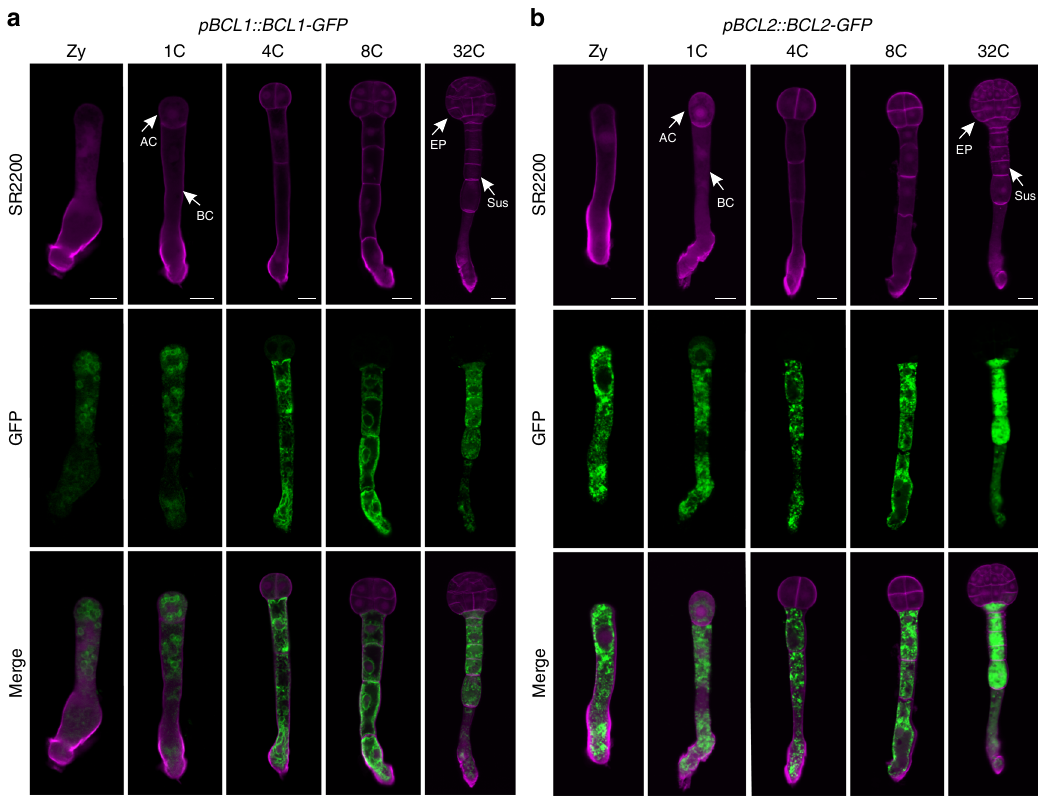
Fig. 5 Expression pattern of selected basal cell lineage-maintained genes validates the transcriptomic analysis. a , b Spatio-temporal expression of BCL1 ( a ) and BCL2 ( b ) in early embryogenesis. Zy zygote, 1C 1-cell embryo, 4C 4-cell embryo, 8C 8-cell embryo, 32C 32-cell embryo, AC apical cell, BC basal cell, EP embryo proper, Sus suspensor. Bar = 10 μ